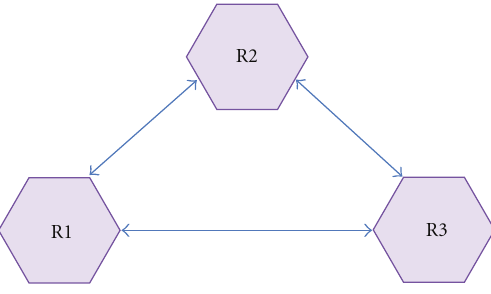
Figure 3: The topology model of the robots in